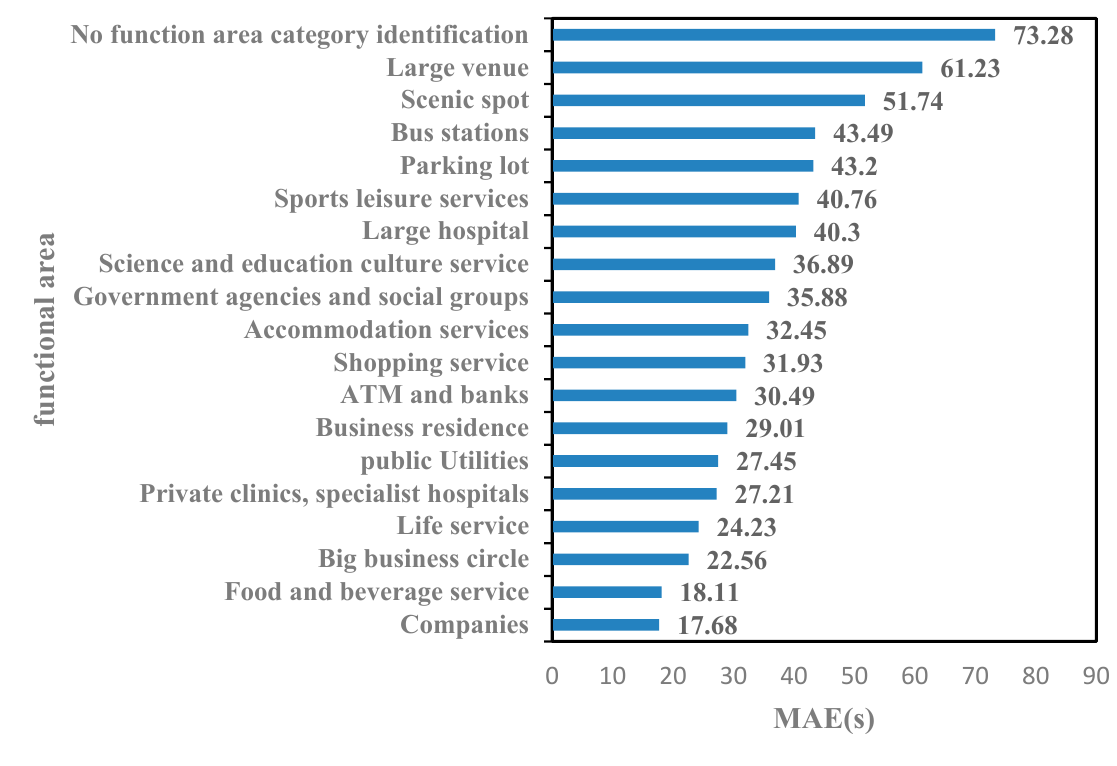
Figure 9. Prediction effect of different functional areas.